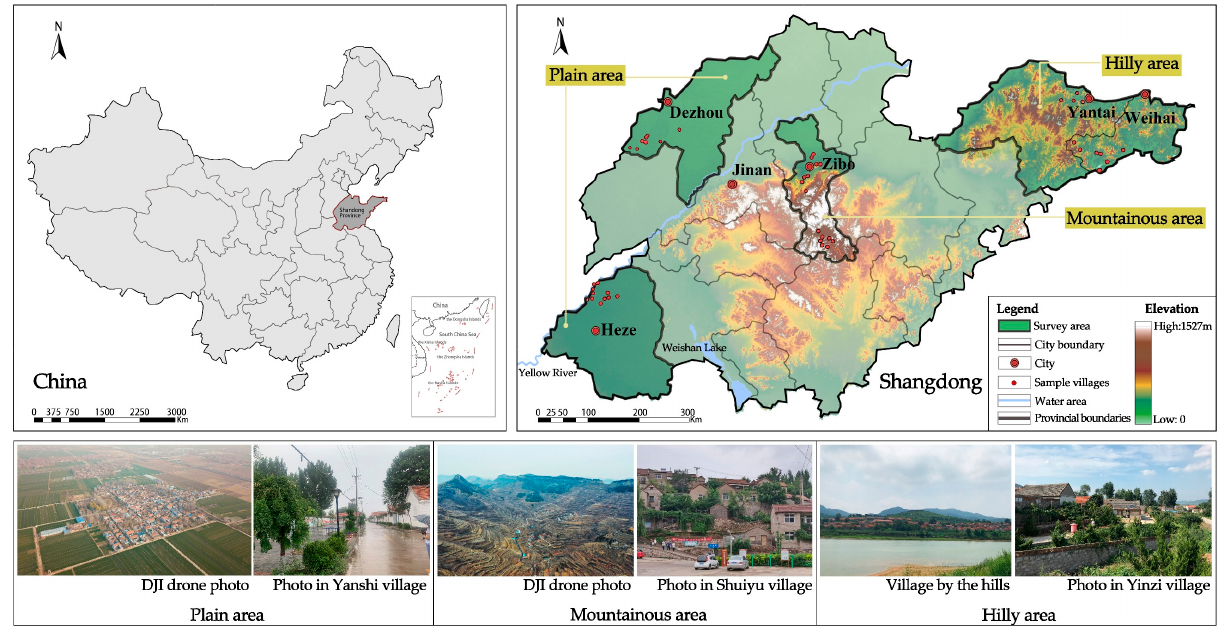
Figure 1. Location, topographic map, and photos of the study areas.